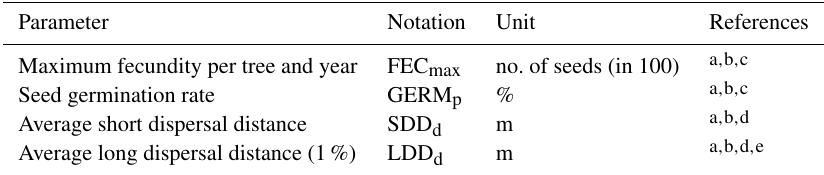
Table 2. Description of the migration parameters and data source.